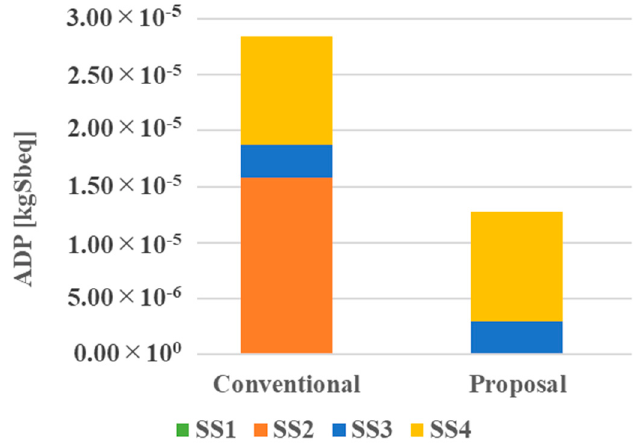
Figure 9. Results of ADP of the conventional and proposed cases.